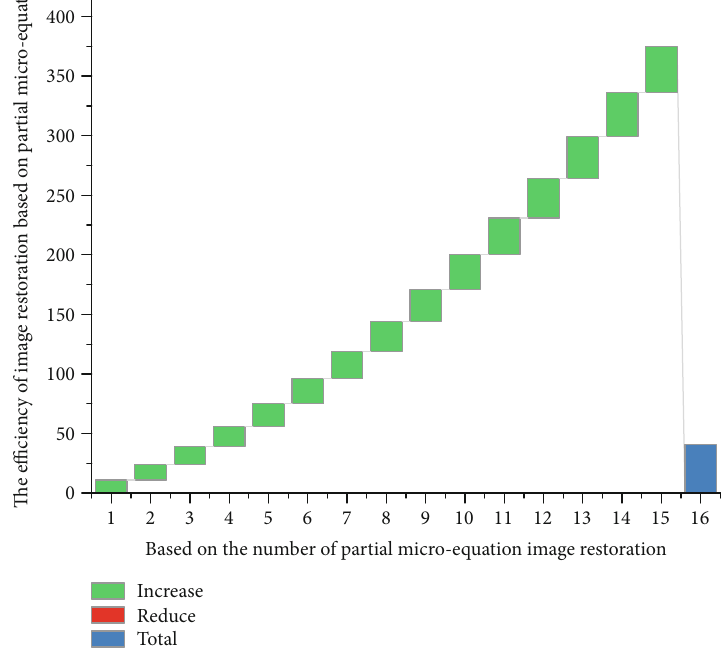
Figure 7: Segmented image.